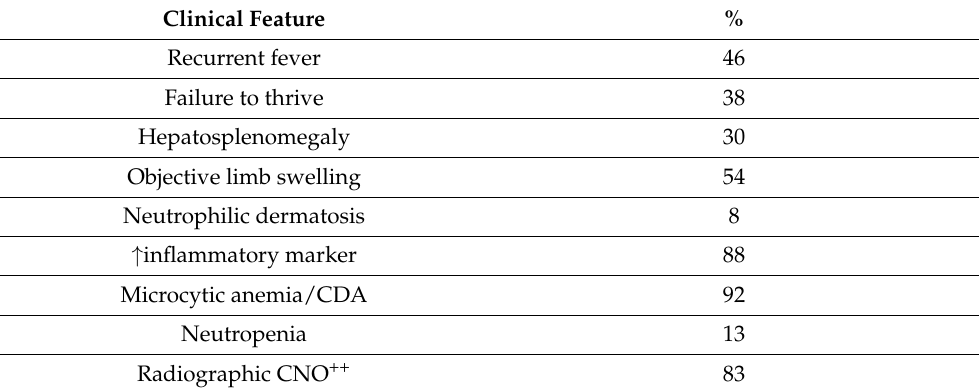
Table 2. Majeed Clinical